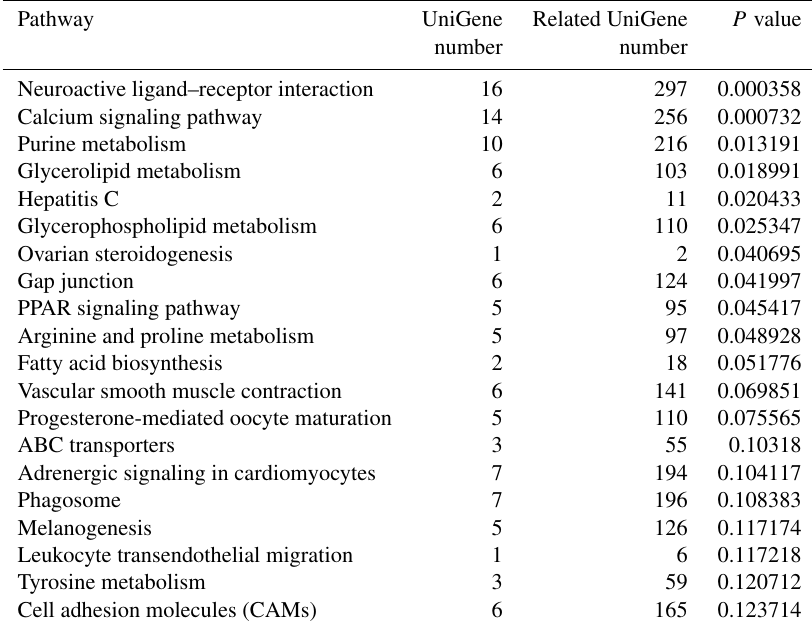
Table 5. List of KEGG pathway for differentially expressed genes. Pathway UniGene Related UniGene P value Neuroactive ligand–receptor